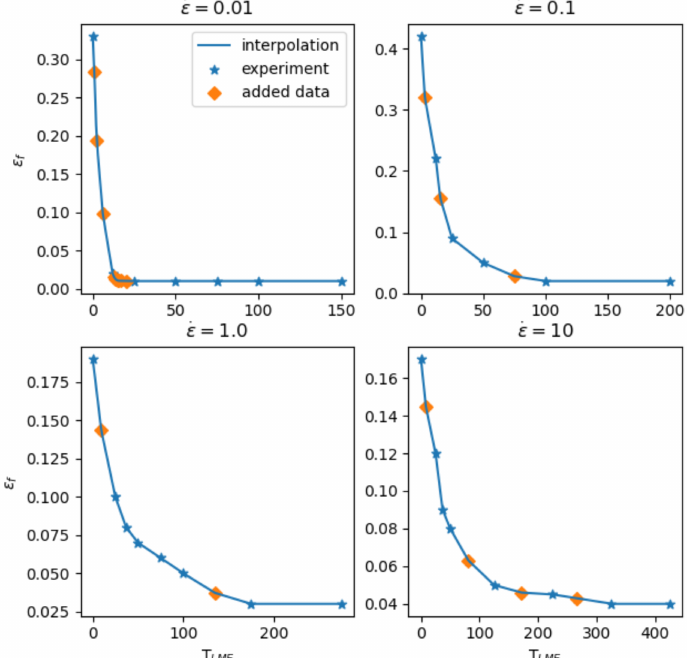
Figure 7. Experimental data points and added auxiliary points in temperature